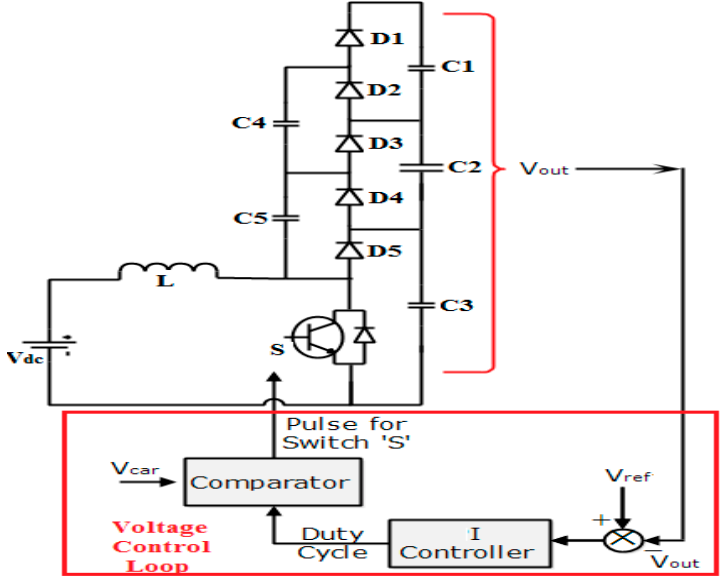
Figure 6. Model of TLBC in closed-loop mode.